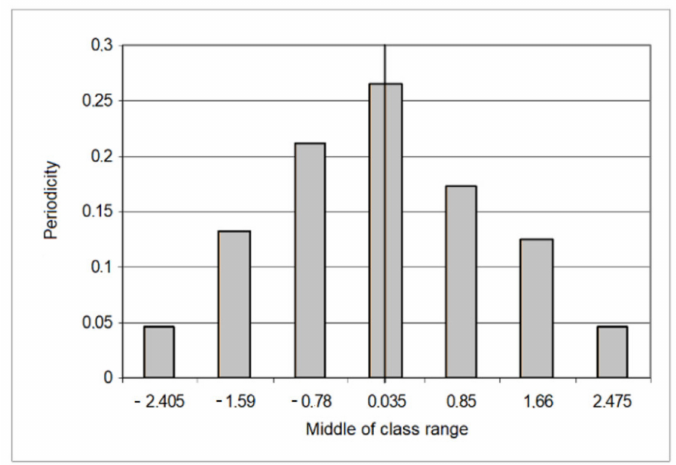
Figure 21. Histograms of changes in the periodicity in the middle of class range.